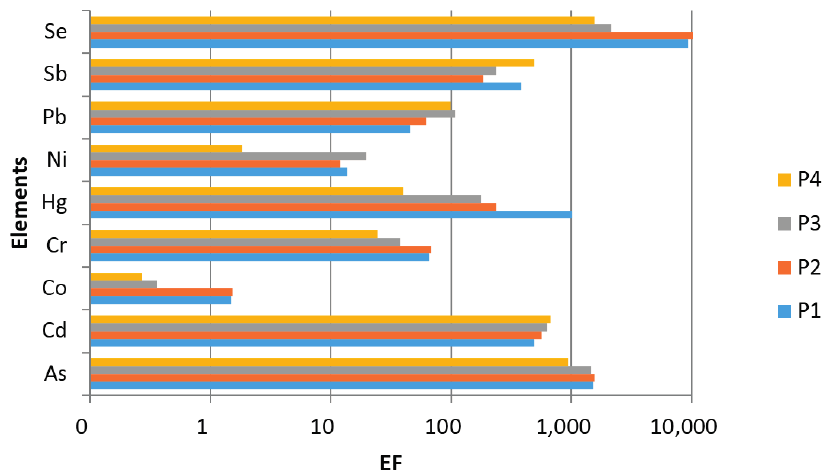
Figure 4. Enrichment factors of elements with Mn as the reference